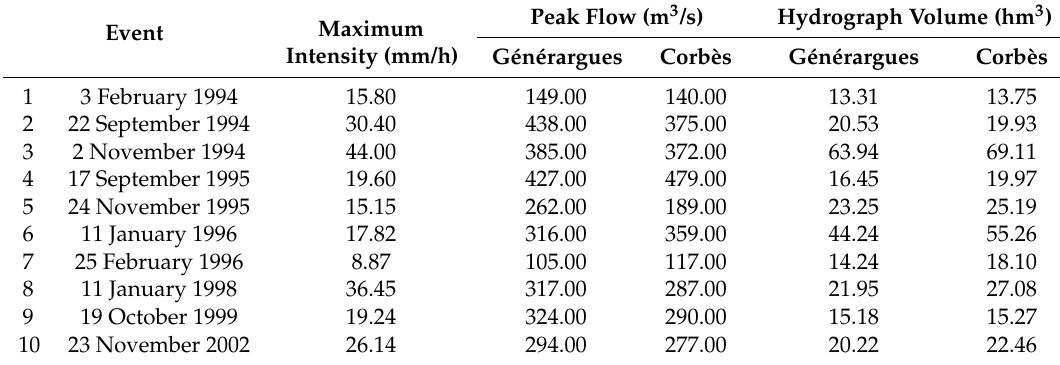
Figure 7. Location of the Saint-Jean-du-Gard and the Mialet basins. Table 3. Flood events used for calibration of the RIBS model.